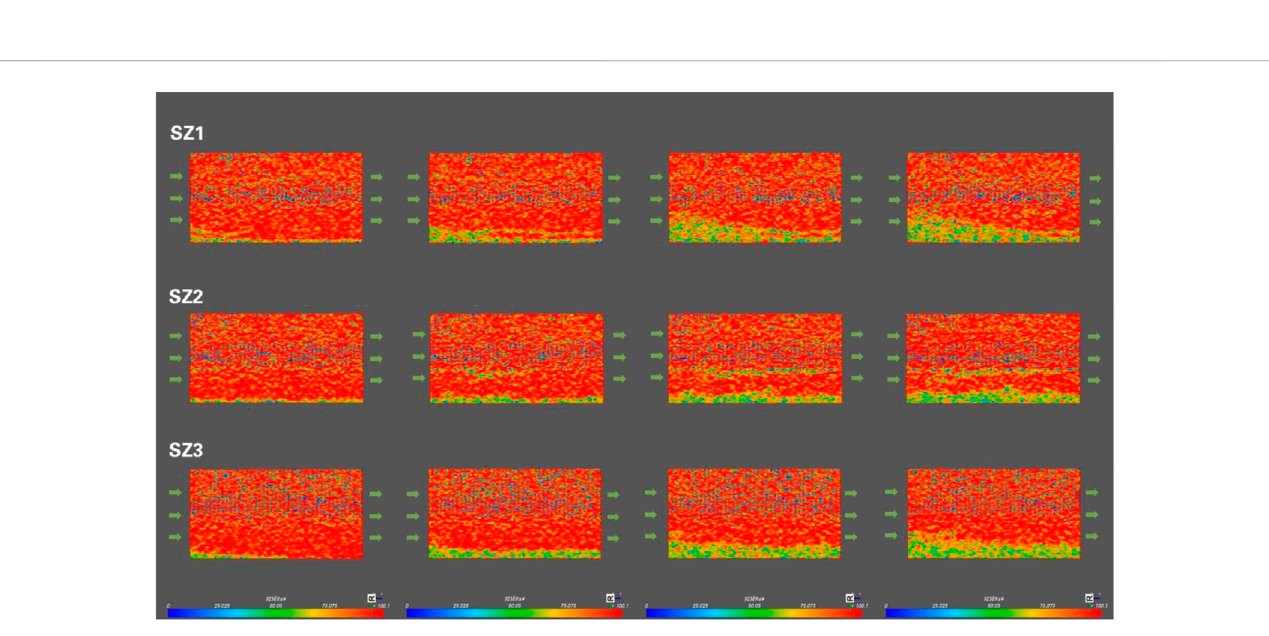
FIGURE 7 Oil saturation distribution of 3 groups of positive rhythm models (central